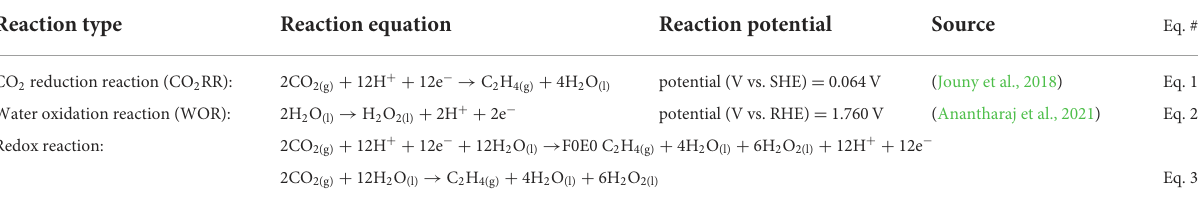
TABLE 3 Half-cell reactions resulting in C 2 H 4 and H 2 O 2 formation based on CO 2 and H 2 O. Reaction